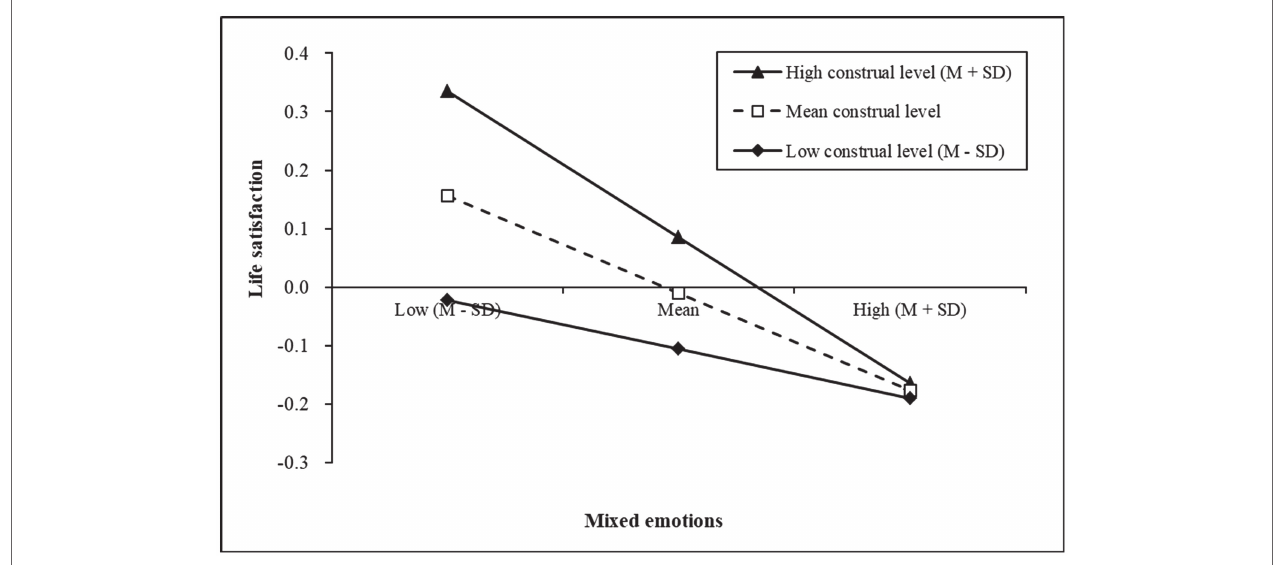
FIGURE 3 | Simple slopes of construal level moderate the relationship between mixed emotions and life satisfaction.